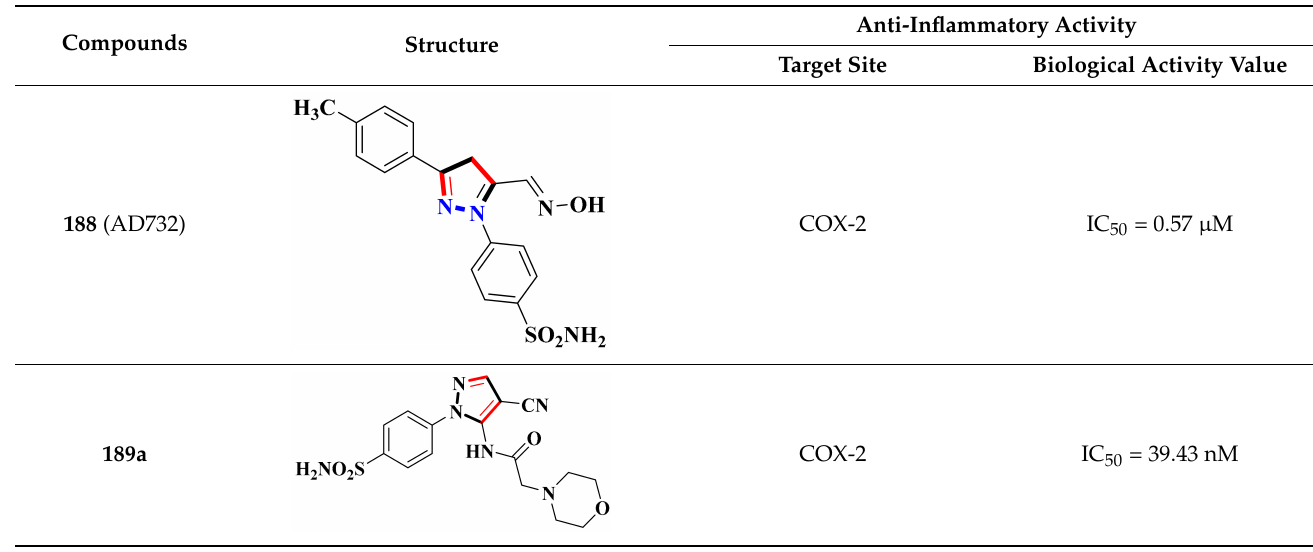
Table 14. Representative compound structures 188 to 191 and their anti-inflammatory